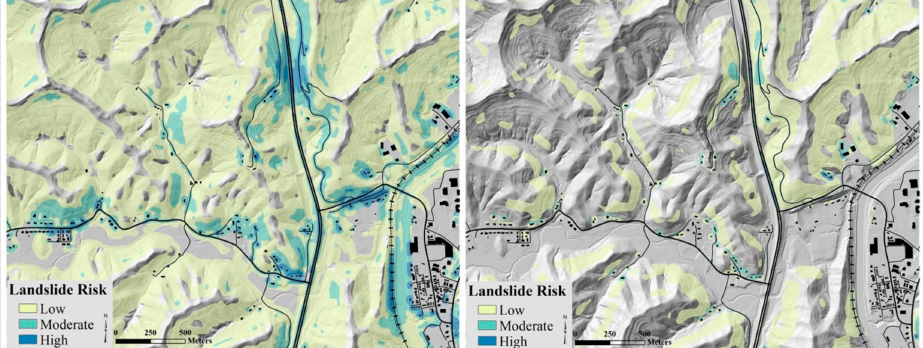
Figure 13. Comparison of the susceptibility-based map ( left ) and slope-based risk map ( right ) for part of Pike County. The block group-based population data and coarse slope map input creates stark boundaries in risk classes ( right ). The northeast portion of the slope-based map ( right ) shows how low population removes all risk, except for areas directly adjacent to buildings roads. While not inaccurate, the remaining area shows that more highly populated block-groups do not have such stark skews.